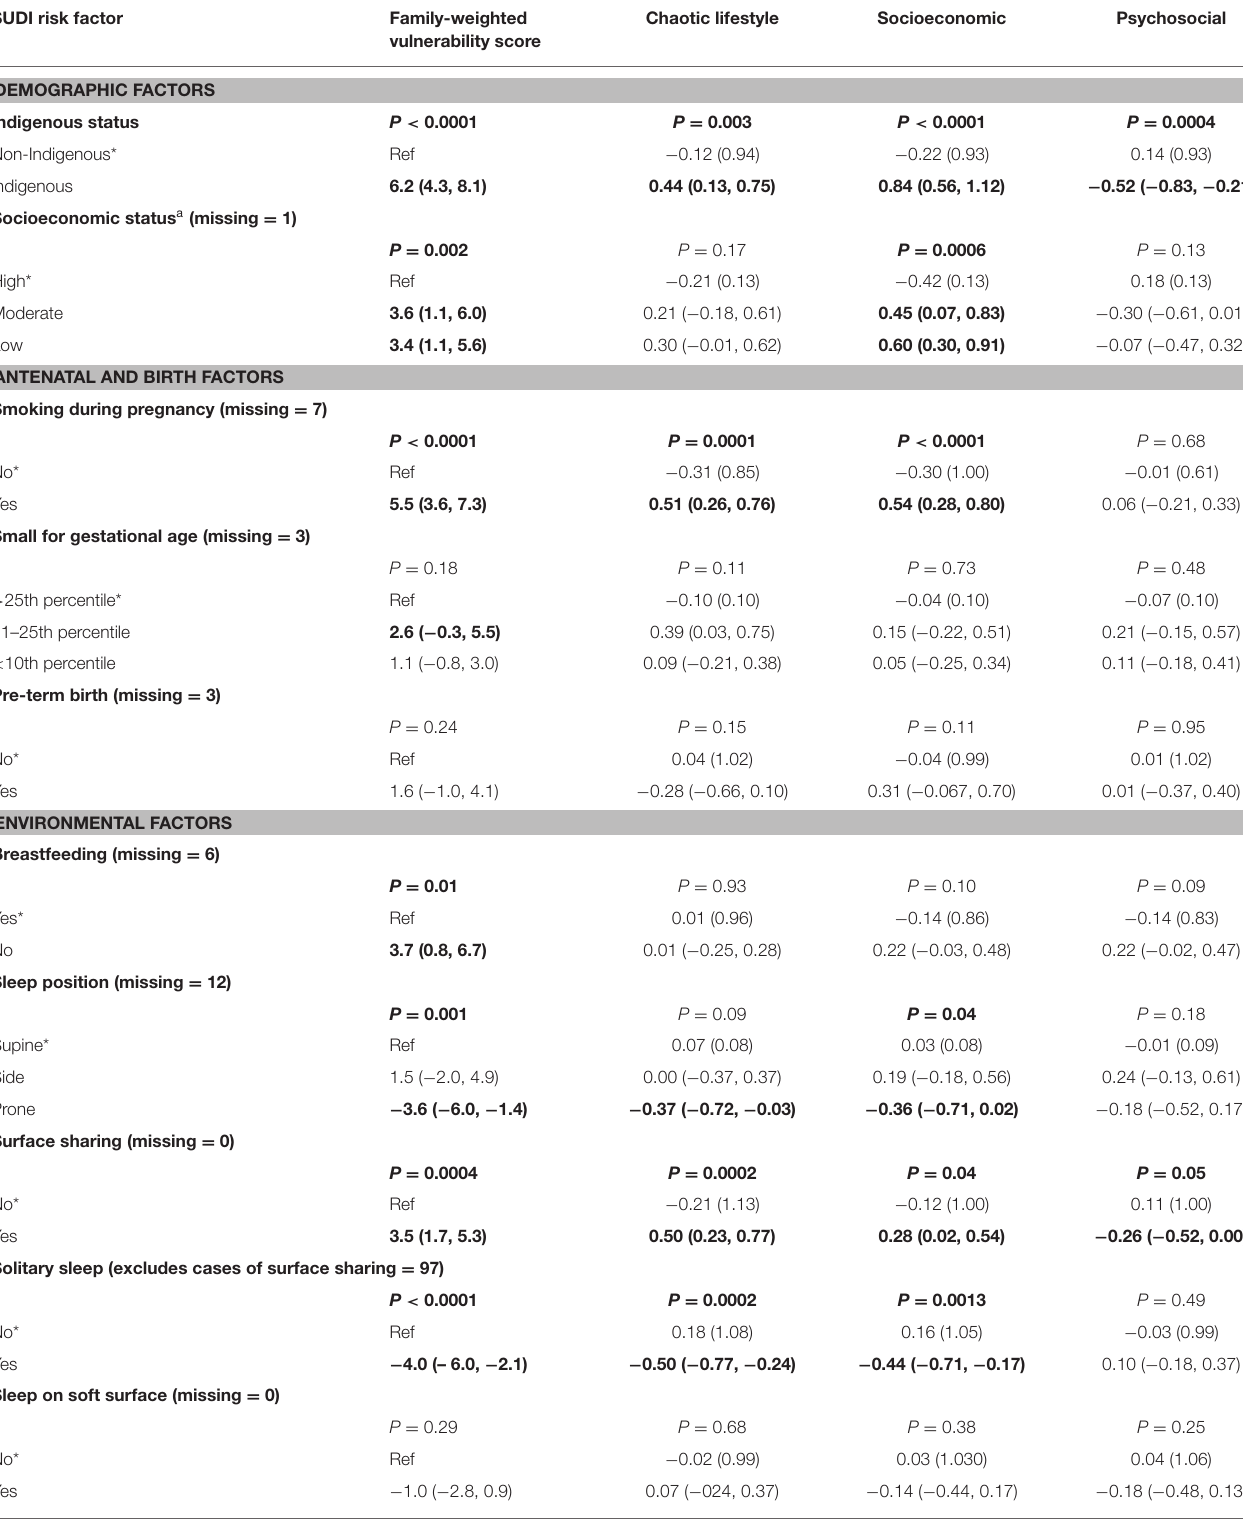
TABLE 2 | Association of family-weighted vulnerability score and vulnerability types by SUDI risk factors. SUDI risk factor Family-weighted Chaotic lifestyle Socioeconomic vulnerability score